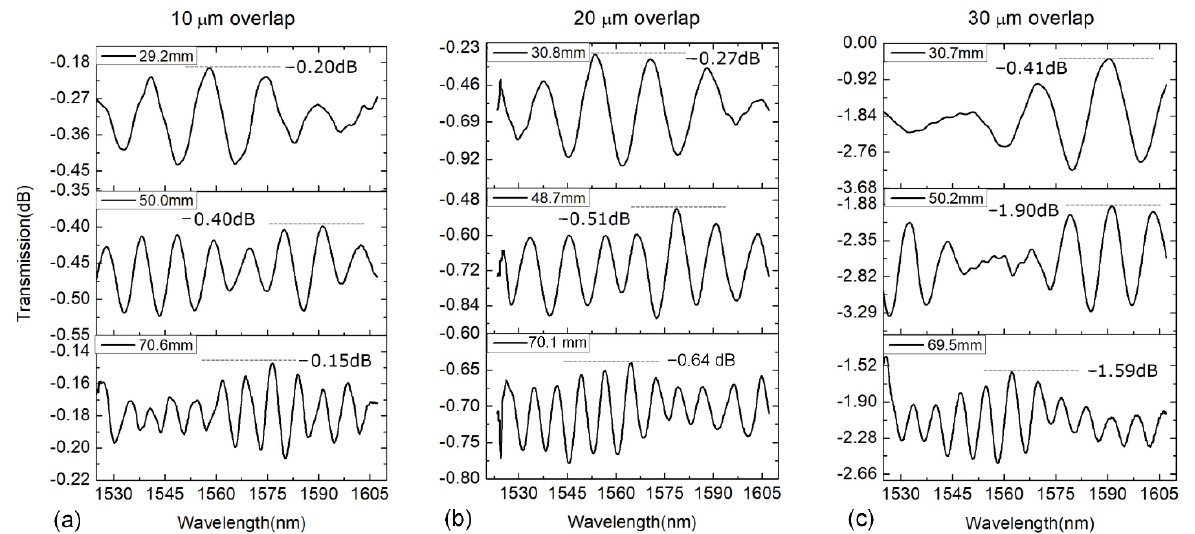
Figure 3. Transmission spectra of WWFT-based interferometers with different overlap values of ( a ) 10 µ m, ( b ) 20 µ m and ( c ) 30 µ m, respectively.